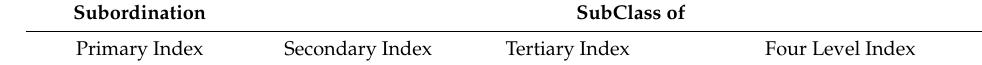
Table 3. OWL examples of assembly knowledge